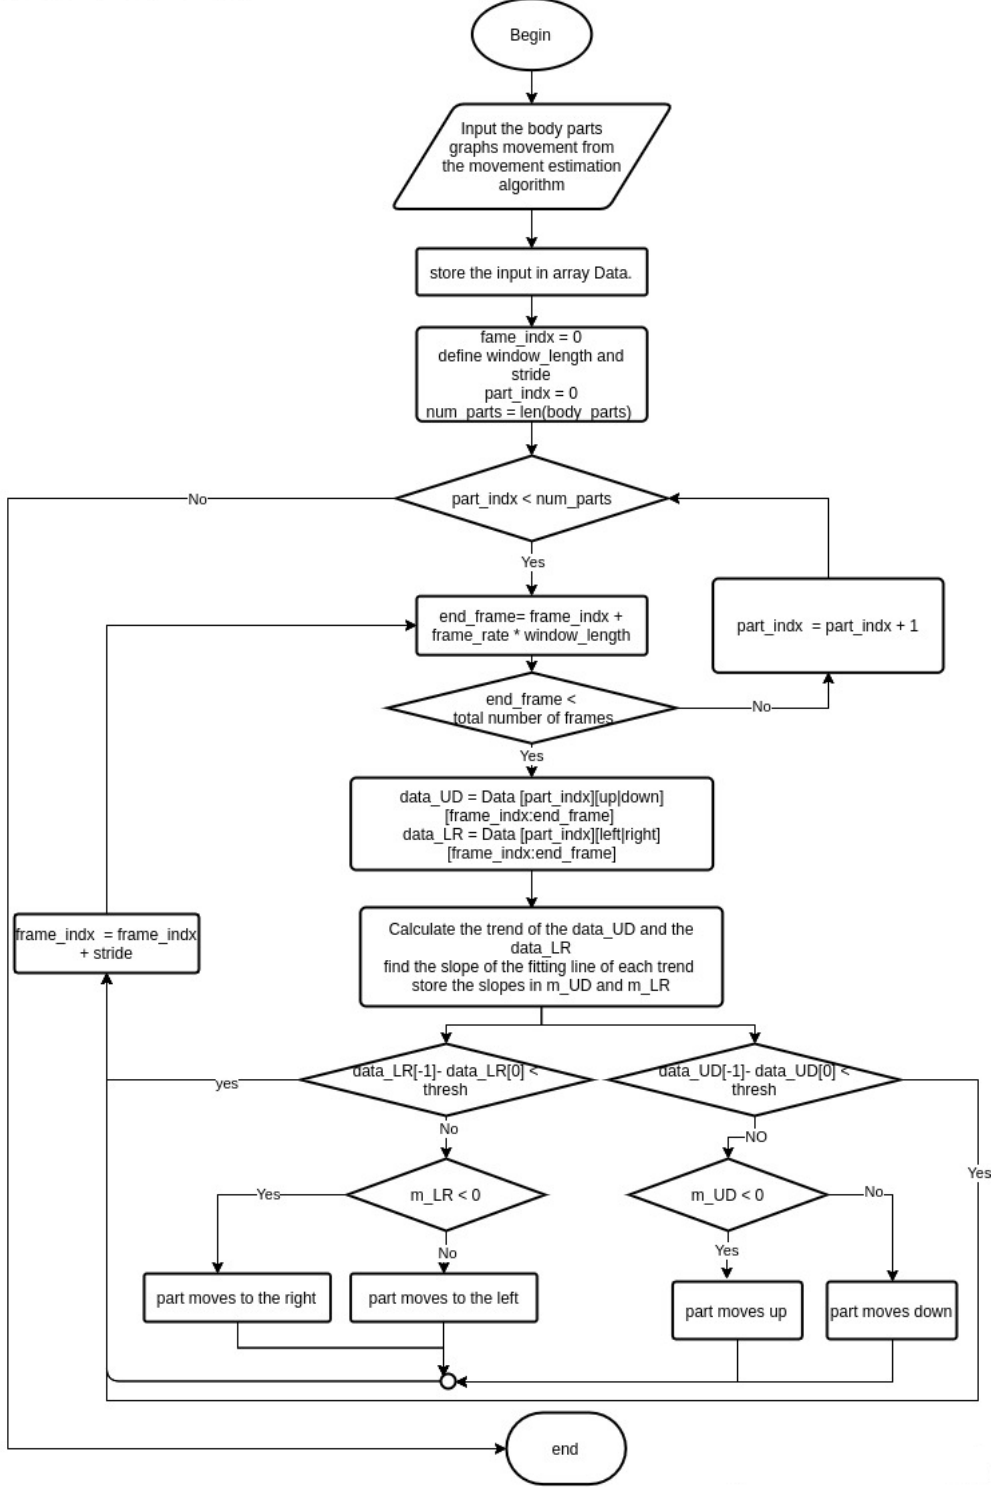
Figure 7. Movement analysis